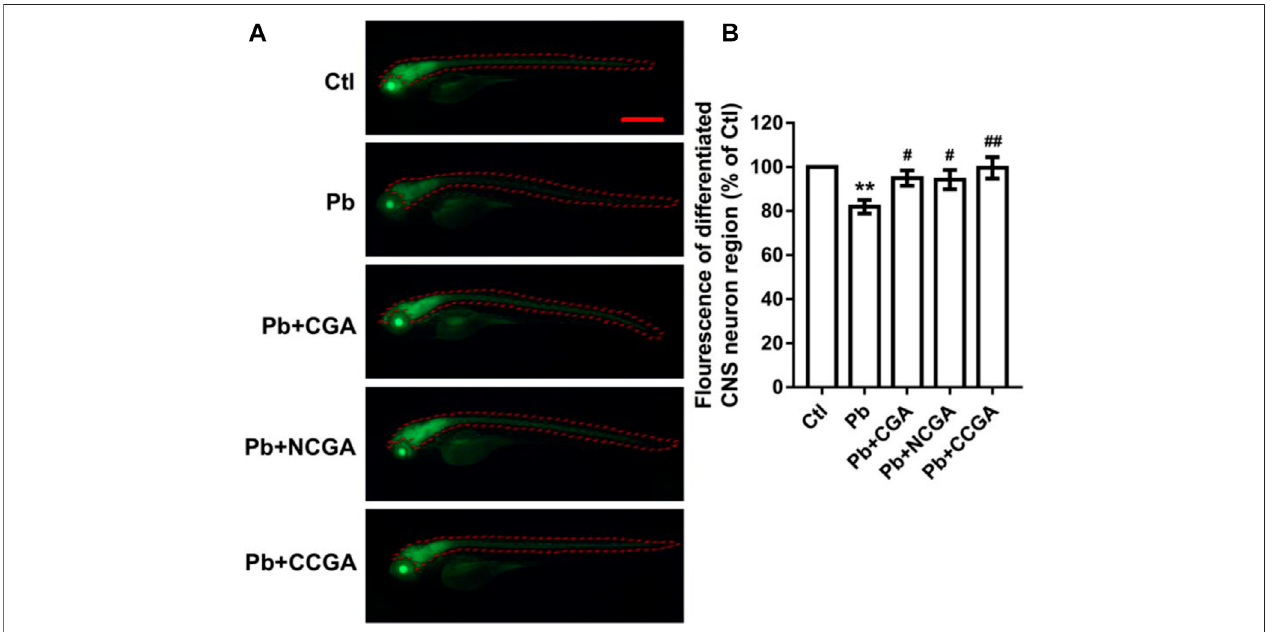
FIGURE 4 | Representative fl uorescence images of differentiated CNS neuron region of zebra fi sh and its analysis. (A) Representative fl uorescence microscopy images of elavl3:EGFP zebra fi sh at 120 hpf (scale bar, 500 μ m). (B) Statistical analysis of the fl uorescence of differentiated CNS neuron region ( n (cid:1) 6); ** p < 0.01 vs. control and # p < 0.05, ## p < 0.01 vs. Pb.